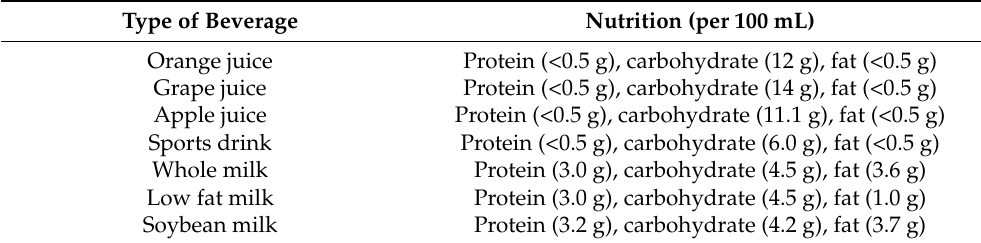
Table 1. Composition for the beverages used in this